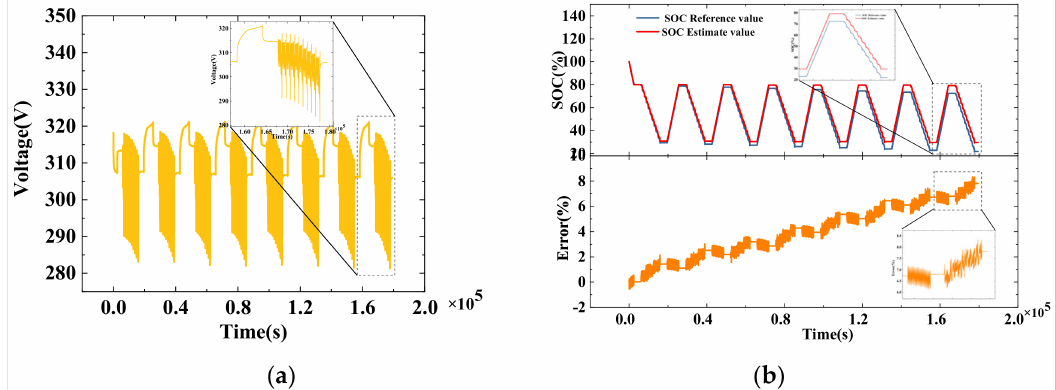
Figure 12. Test results of NEDC profile: ( a ) battery voltage curve; ( b ) SOC curve.